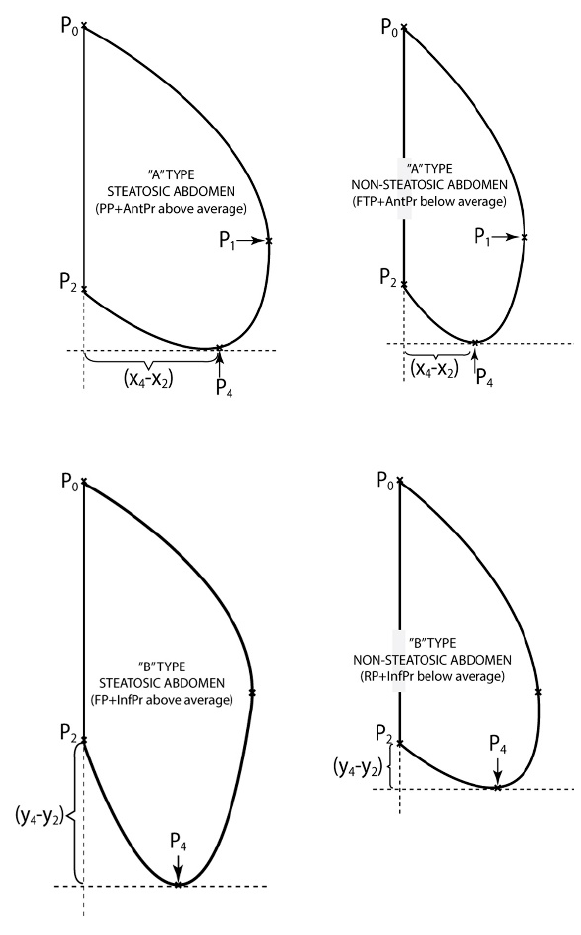
Figure 5. Models of abdominal profiles B.